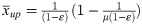
Illustration of Non-chaotic Aperiodic Oscillations (NAO).Time series are for different combinations of the gain parameter ε and growth rate μ: (T1) ε = 0.005, μ = 3.8; (T2) ε = 0.005, μ = 3.9; (T3) ε = 0.05, μ = 3.9 and (T4) ε = 0.1, μ = 3.75. Only 500 generations are used in all four plots after discarding transients. Two horizontal lines are given by x¯up=1(1−ε)(1−1μ(1−ε)) and x¯low=1(1+ε)(1−1μ(1+ε)). The two values are derived from the analysis of the simplified version of (2) for n = 1 and n = 0, respectively. The time series T4 is plotted on a different y–scale to emphasize small fluctuations in the time series. The dashed-line represents the unstable fixed point of the map with ε = 0.